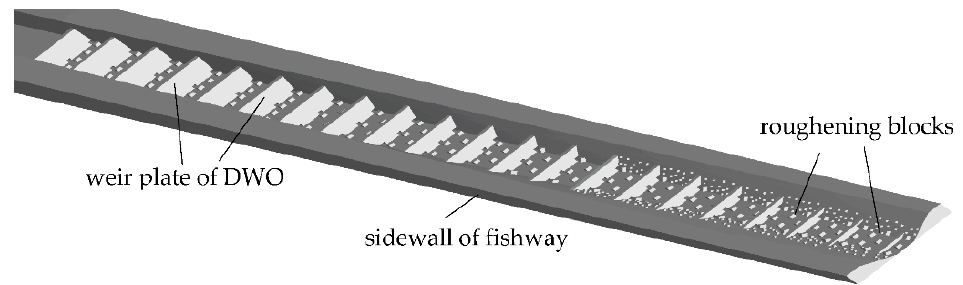
Figure 8. Three-dimensional numerical simulation model of the transition reach with the DWO. There are 21 multistage weirs and 61 orifices to maintain the flow discharge smoothly with double passages, and many bottom roughening blocks are set up to add roughness to the boundary so as to reduce the flow velocity, which is beneficial for resting fish.